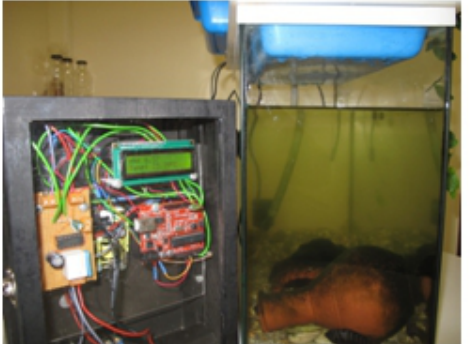
Figure 17. Photo of the control system and